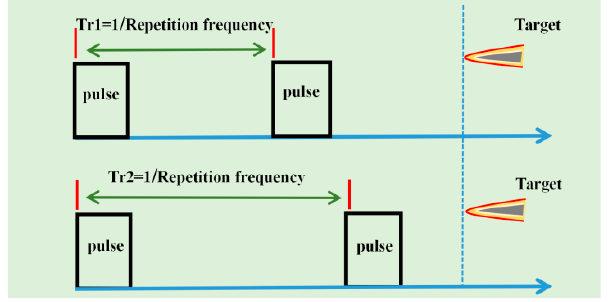
Figure 4. Diagram of multi-repetition frequency.